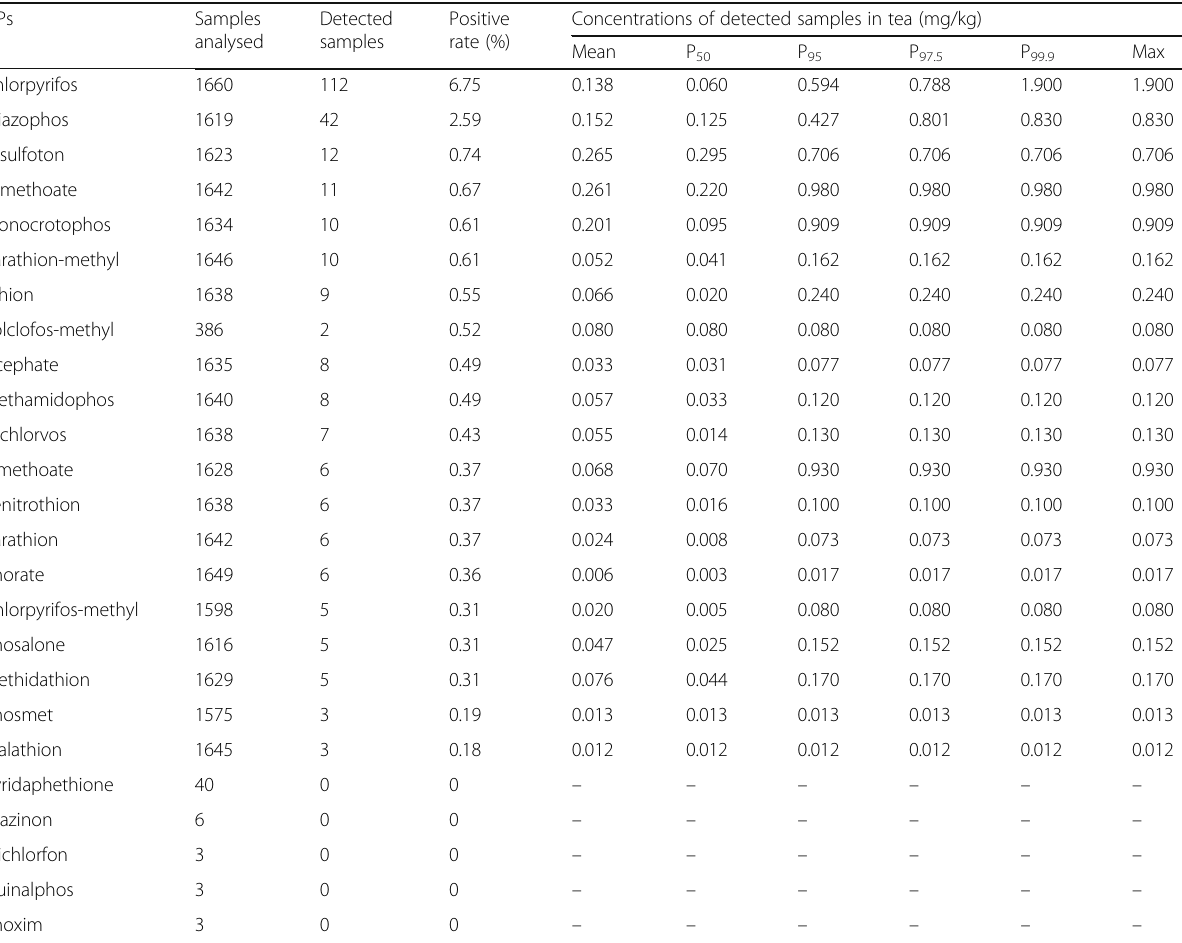
Table 2 Concentrations of OPs in tea from the 2013 – 2014 National Monitoring Program OPs